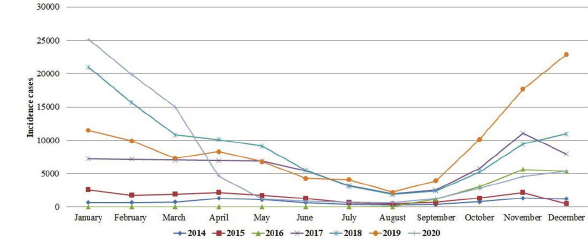
Figure 3 - Incidence cases of chickenpox by